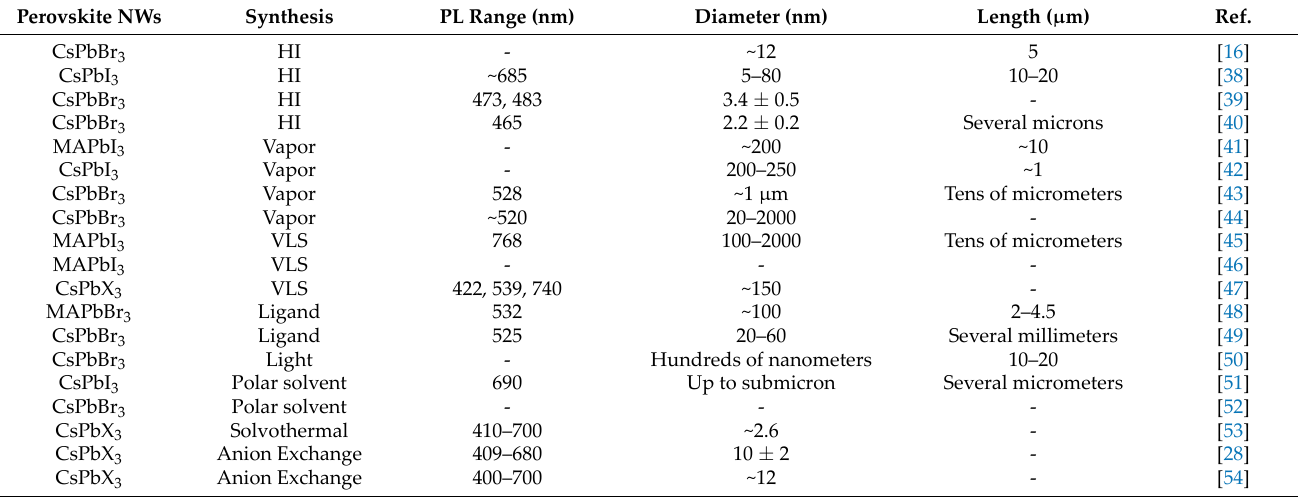
Figure 1. ( a ) One unit cell structure of ABX 3 perovskites. ( b ) Extended network of ABX 3 perovskites connected by corner ‐ shared octahedrons. ( c ) Schematic illustrations of HI synthesis of colloidal CsPbX 3 NCs. ( d ) Different colloidal dispersions in toluene under UV lamp ( λ = 365 nm) and their representative PL spectra. Reprinted with permission from reference [37]. Copyright 2015, American Chemical Society. Table 1. Typical NW parameters obtained from different synthetic methods. Perovskite